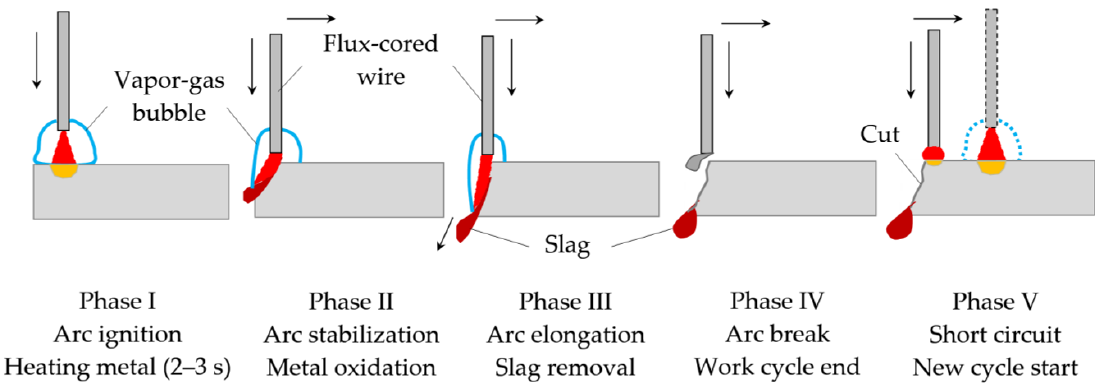
Figure 4. Mechanism of underwater wet cutting using flux-cored wires.